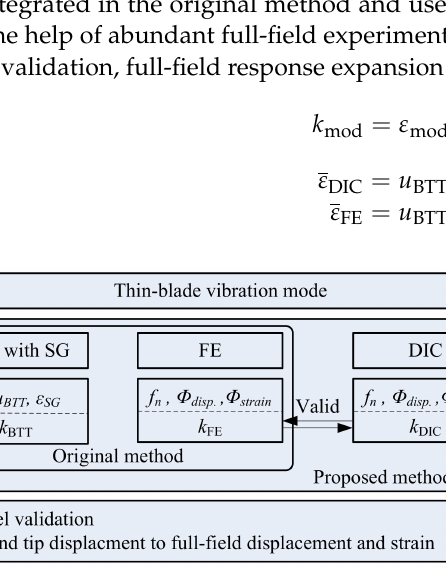
Figure 4. Methodology